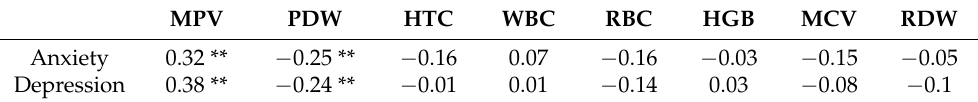
Table 3. Correlations between hematological parameters with anxiety and depression symptoms. MPV PDW HTC WBC Anxiety